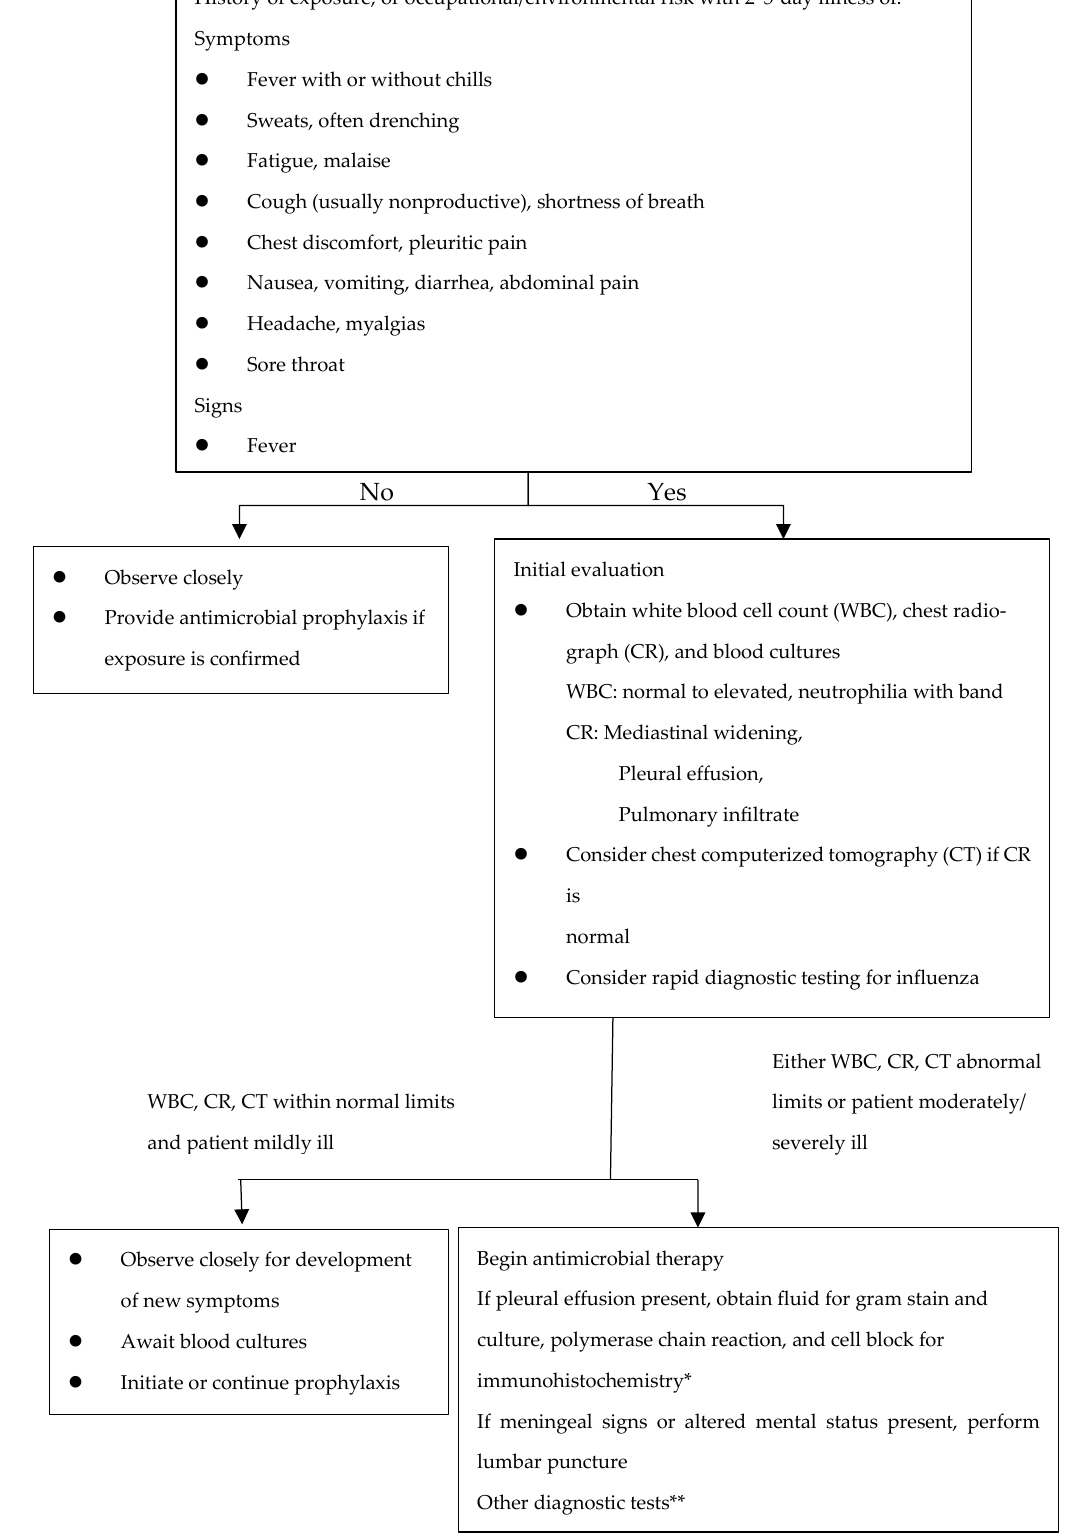
Figure 8. Recommended clinical evaluation for patients with possible inhalational anthrax. * Available through CDC or LRN. Cell block obtained by centrifugation of pleural fluid. ** Serologic testing available at CDC may be an additional diagnostic technique.